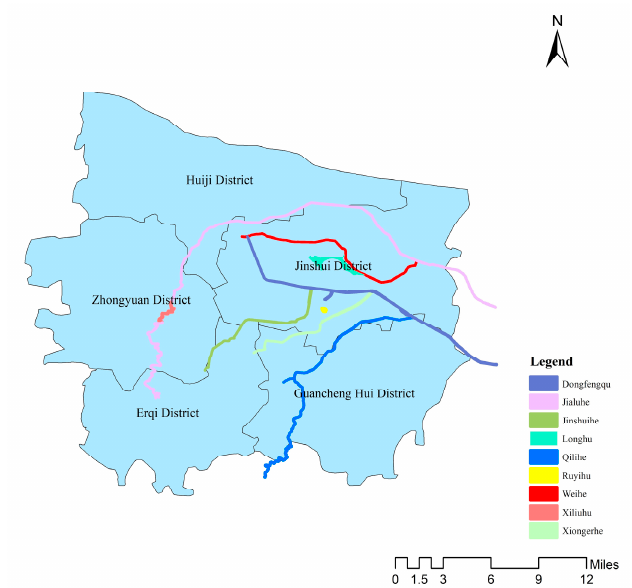
Figure 1. Distribution of main urban areas and water systems in Zhengzhou.